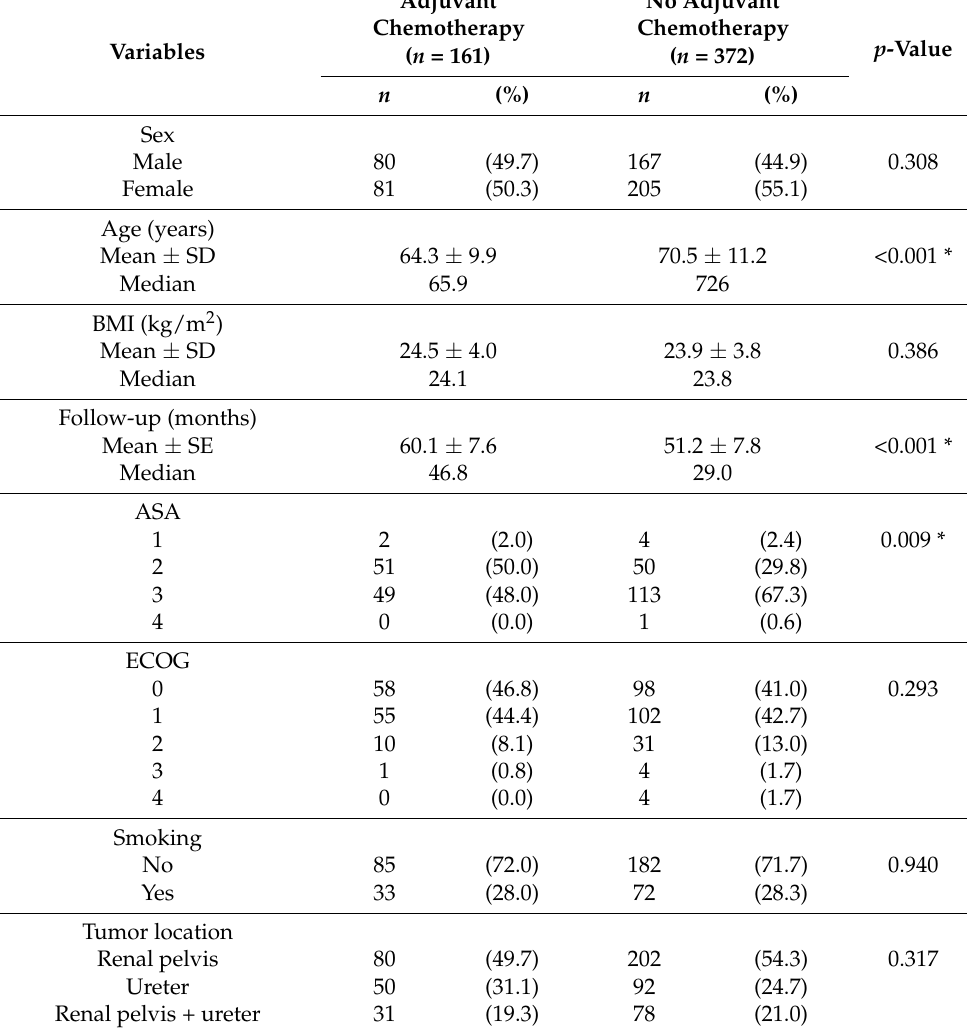
Table 1. Patients’ demographic and clinicopathological characteristics.